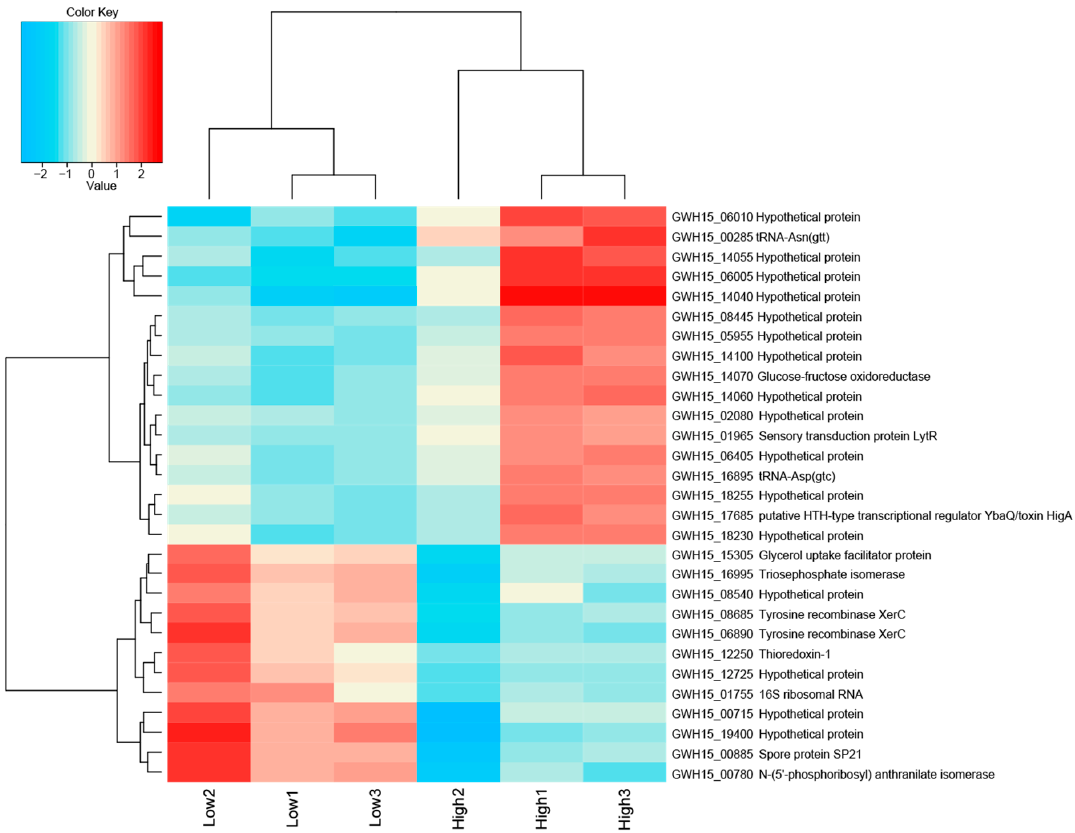
Figure 3. Heatmap of transcriptome data showing the top differentially expressed genes log 2 > 1.5-fold and hierarchical clustering analysis in high-sugar versus low-sugar conditions. High to low expression is shown by a gradient color from red to blue, respectively.